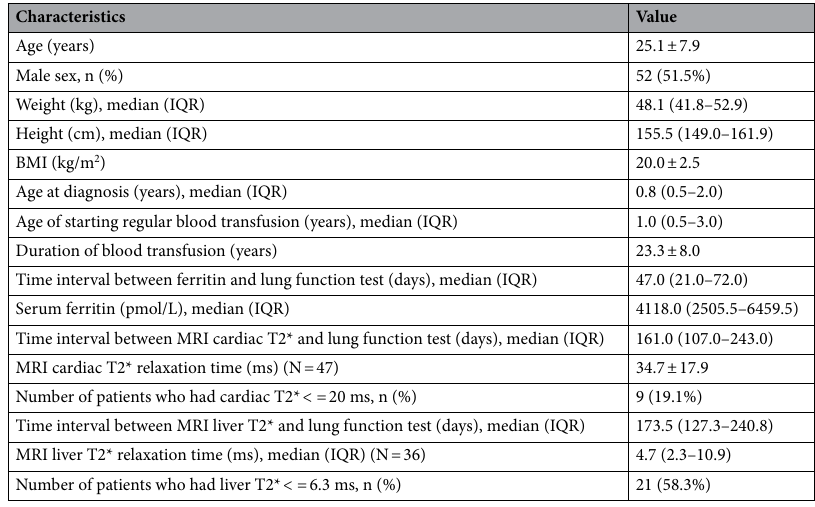
Table 1. Clinical characteristics of the participants (N = 101). Values are presented as mean ± standard deviation unless otherwise specified. BMI, body mass index; IQR, interquartile range; MRI, magnetic resonance imaging.